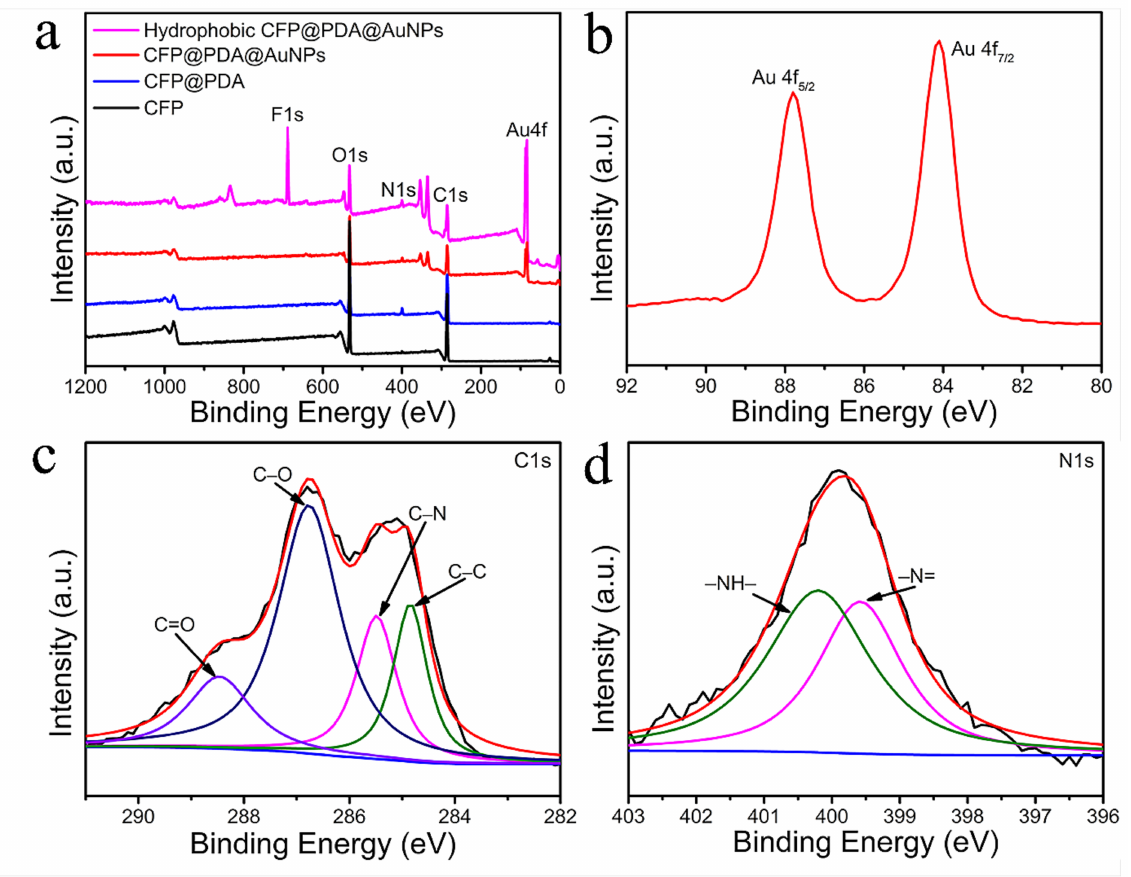
Figure 4. ( a ) XPS wide spectra of the original CFP, CFP@PDA, CFP@PDA@AuNPs and hydrophobic CFP@PDA@AuNPs. ( b ) High-resolution Au 4f spectrum of CFP@PDA@AuNPs. C1s ( c ) and N1s ( d ) peak fitting spectra of